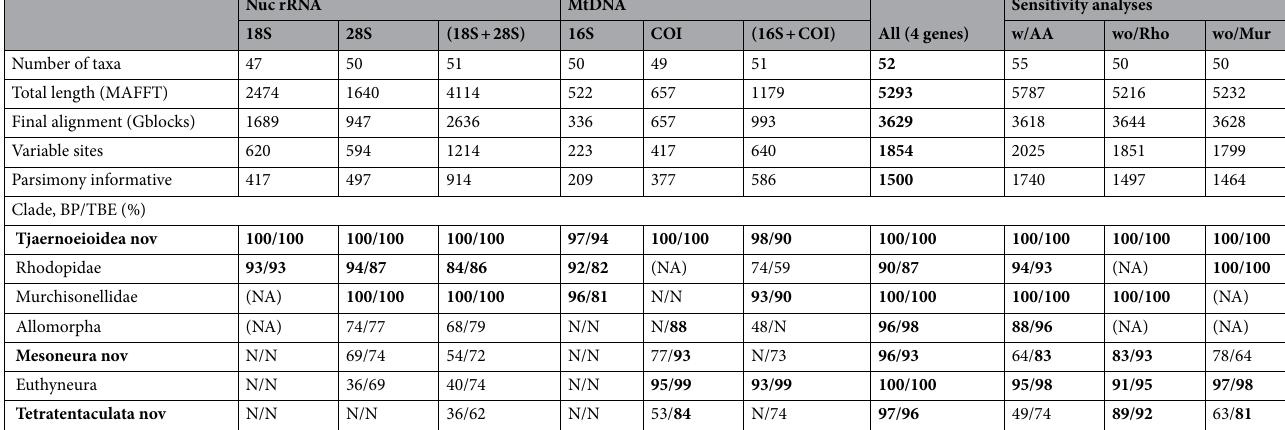
Table 1. Summary of sequence alignment and phylogenetic signals for individual genes and concatenated datasets. Bootstrap proportion (BP) and transfer bootstrap expectation (TBE) are shown as percentages for each clade; bold letters denote significant support (≥ 80%); N, not recovered in best ML tree; NA, not applicable. Sensitivity analyses were run with three additional lower heterobranchs (w/AA) or without Rhodopidae (wo/Rho) or Murchisonellidae (wo/Mur). See Supplementary Figs. S1 and